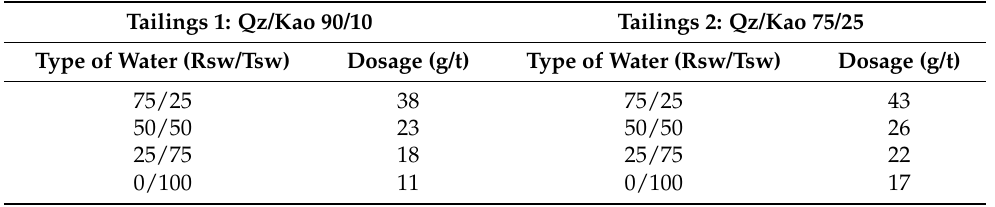
Table 2. Experimental conditions of the eight systems prepared for rheological tests. Qz: quartz, Kao: kaolin, Rsw: raw seawater, Tsw: treated